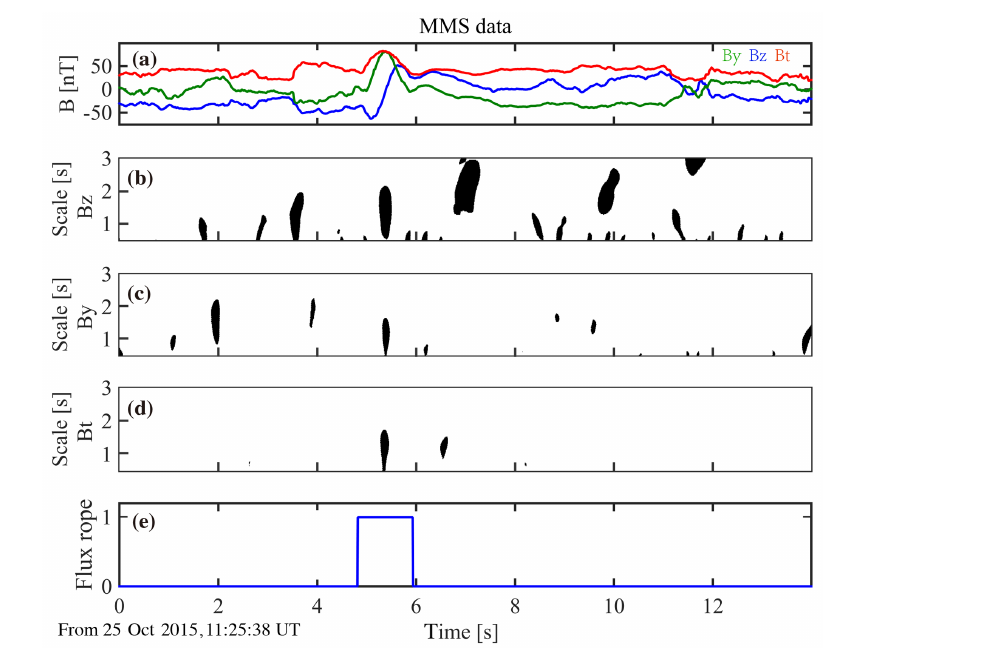
Figure 6. Testing the method on MMS data in the magnetosheath. The same format as in Fig. 5. The scale on the vertical axes of (b–d) uses seconds as the